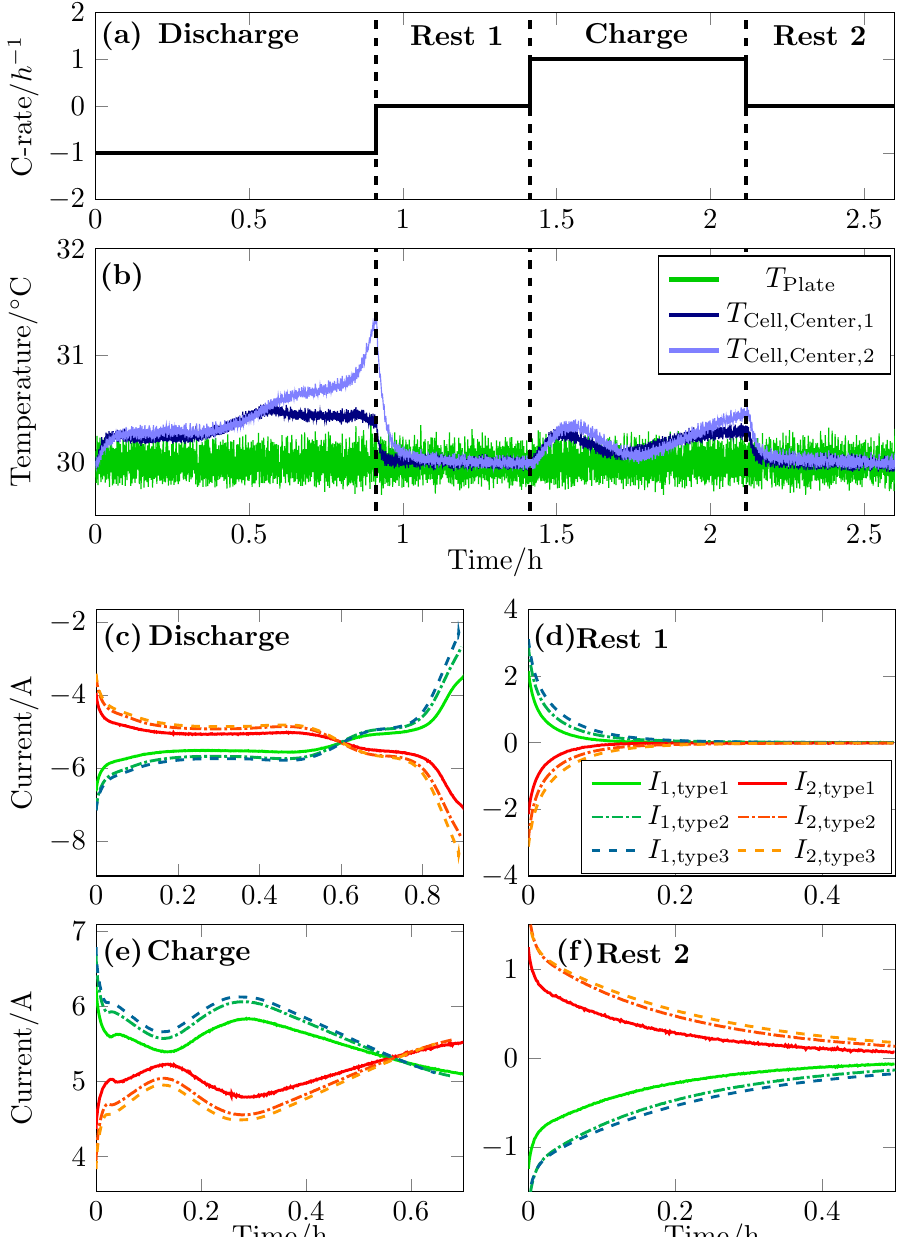
Figure 6. Influence of the cable resistances on the current distribution of two parallel-connected cells. With the current load ( a ), the cell and plate temperature ( b ) and the separated phases: Discharging ( c ), the first rest ( d ), charging ( e ) and the second rest ( f ). The relations of the cable resistances are R Cab,type3 ≈ 3 · R Cab,type2 ≈ 15 · R Cab,type1 , with the exact values in Table